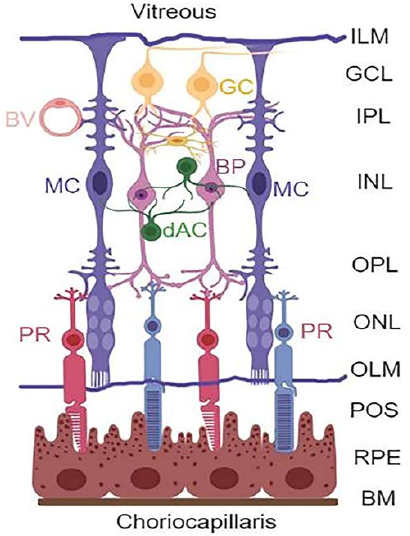
Figure 1. Retinal layers and cell types. The retina is structured in three main neuronal layers: ganglion cell layer (GCL), bipolar neuron layer (BP, INL), and photoreceptor layer (PR, ONL). Between these neuronal layers, axonal-synaptic connections are formed as the inner plexiform layer (IPL) between bipolar and ganglion cells, while the outer plexiform layer (OPL) is the connection between photoreceptors and bipolar neurons. Other retinal neuronal cells include amacrine dopamine (dAC) and horizonal cells. The retina also has macroglia (astrocytes and Müller glial cells) and microglia (immune cells). The astrocytes are found at the GCL or nerve fiber layer on the vitreous side, while MC occupy the entire length of the neuroretina forming inner limiting membrane (ILM) at the vitreous, and the outer limiting membrane (OLM) at the photoreceptor outer segment (POS). Müller cells play critical roles in the formation of neurovascular unit and retinal homeostasis. (Created with BioRender.com, accessed on 9 December 2021).